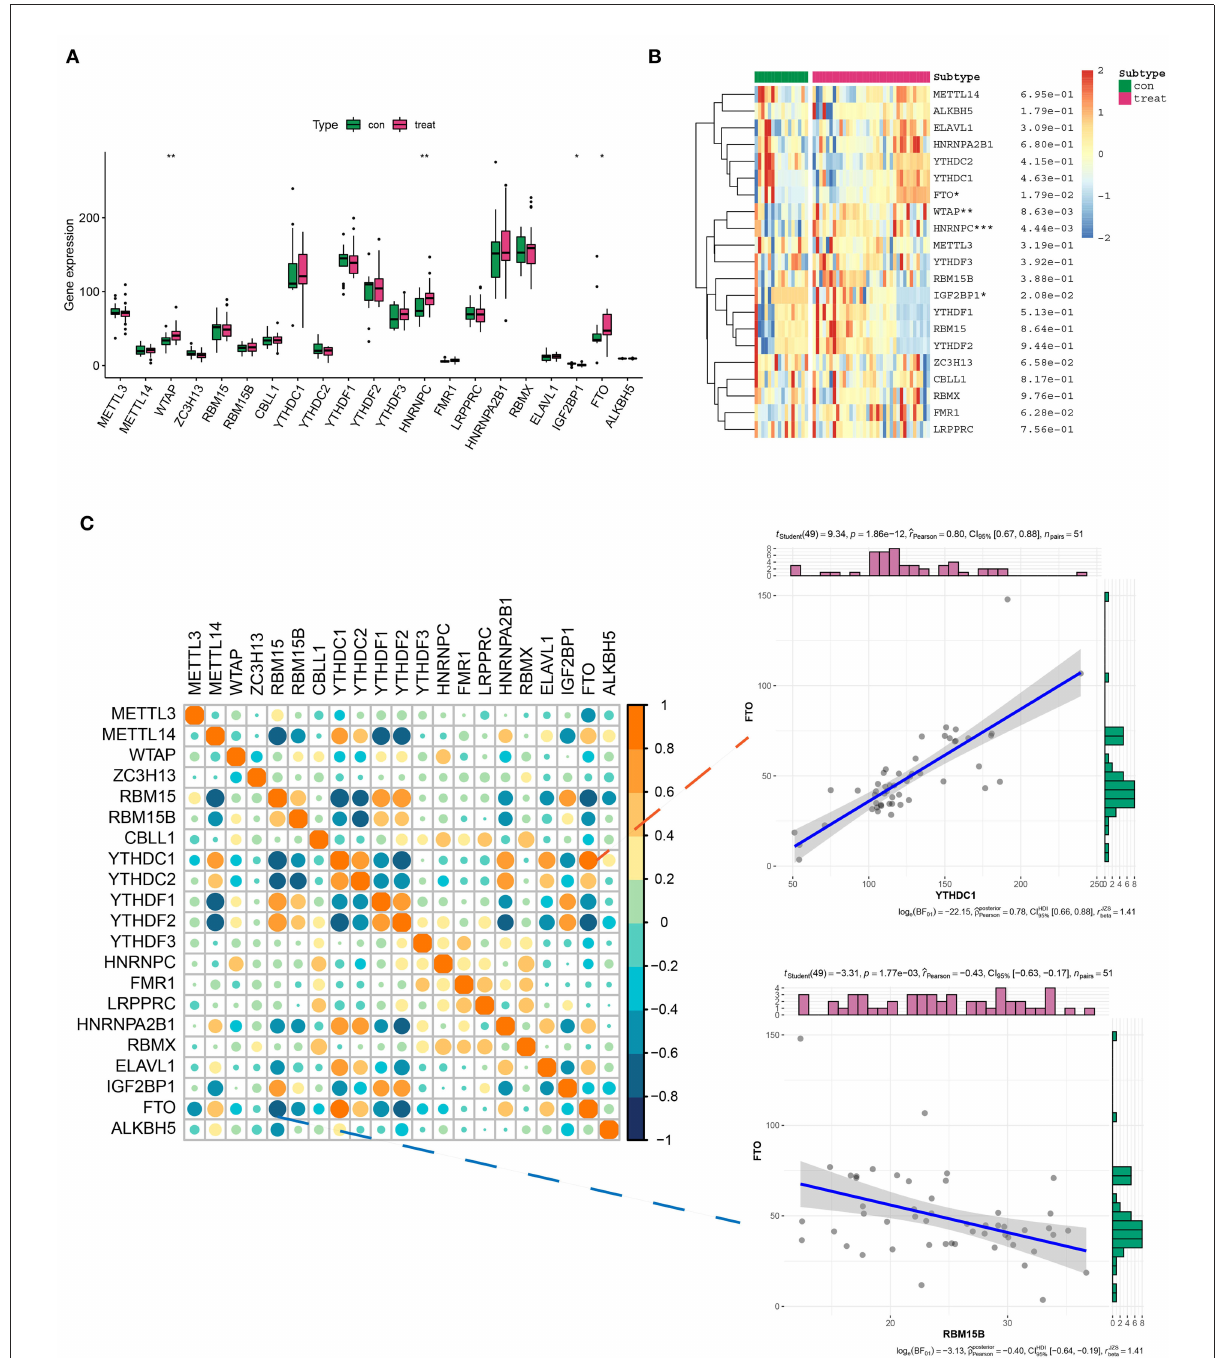
FIGURE1 Differential expression landscape of 21 m6A genes in aortic dissection (AD). (A,B) The box plot and heatmap plot showed the expression level of 21 m6A genes in healthy and AD samples. (C) The correlation between the 21 m6A gene expressions in AD samples. In addition, two scatter plots showed two pairs of highly correlated m6A genes: positive correlation group (FTO and YTHDC1) and negative correlation group (FTO and RBM15B). * p < 0.05, ** p < 0.01, *** p < 0.001 indicated the statistical significance of data.